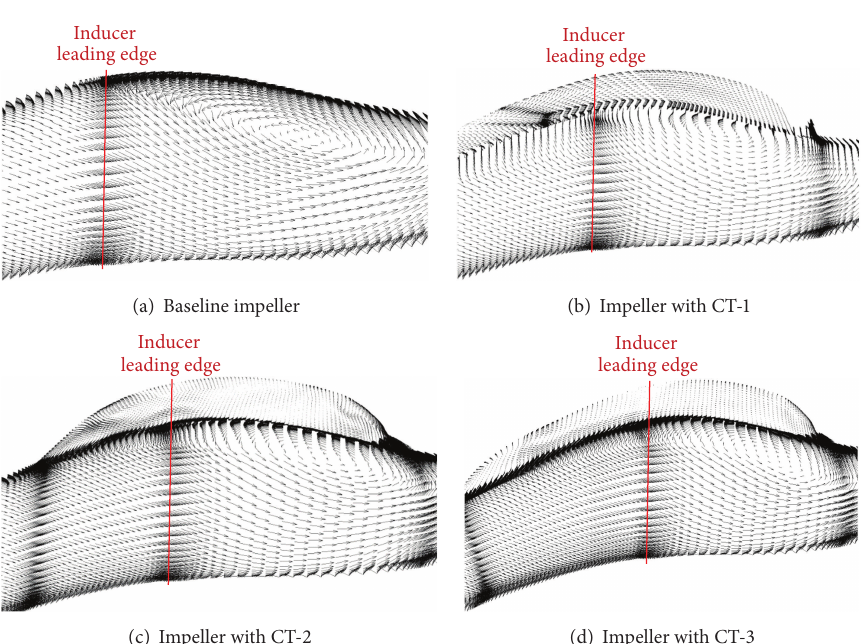
Figure 16: Absolute velocity vectors in the inducer channel and in the casing treatment